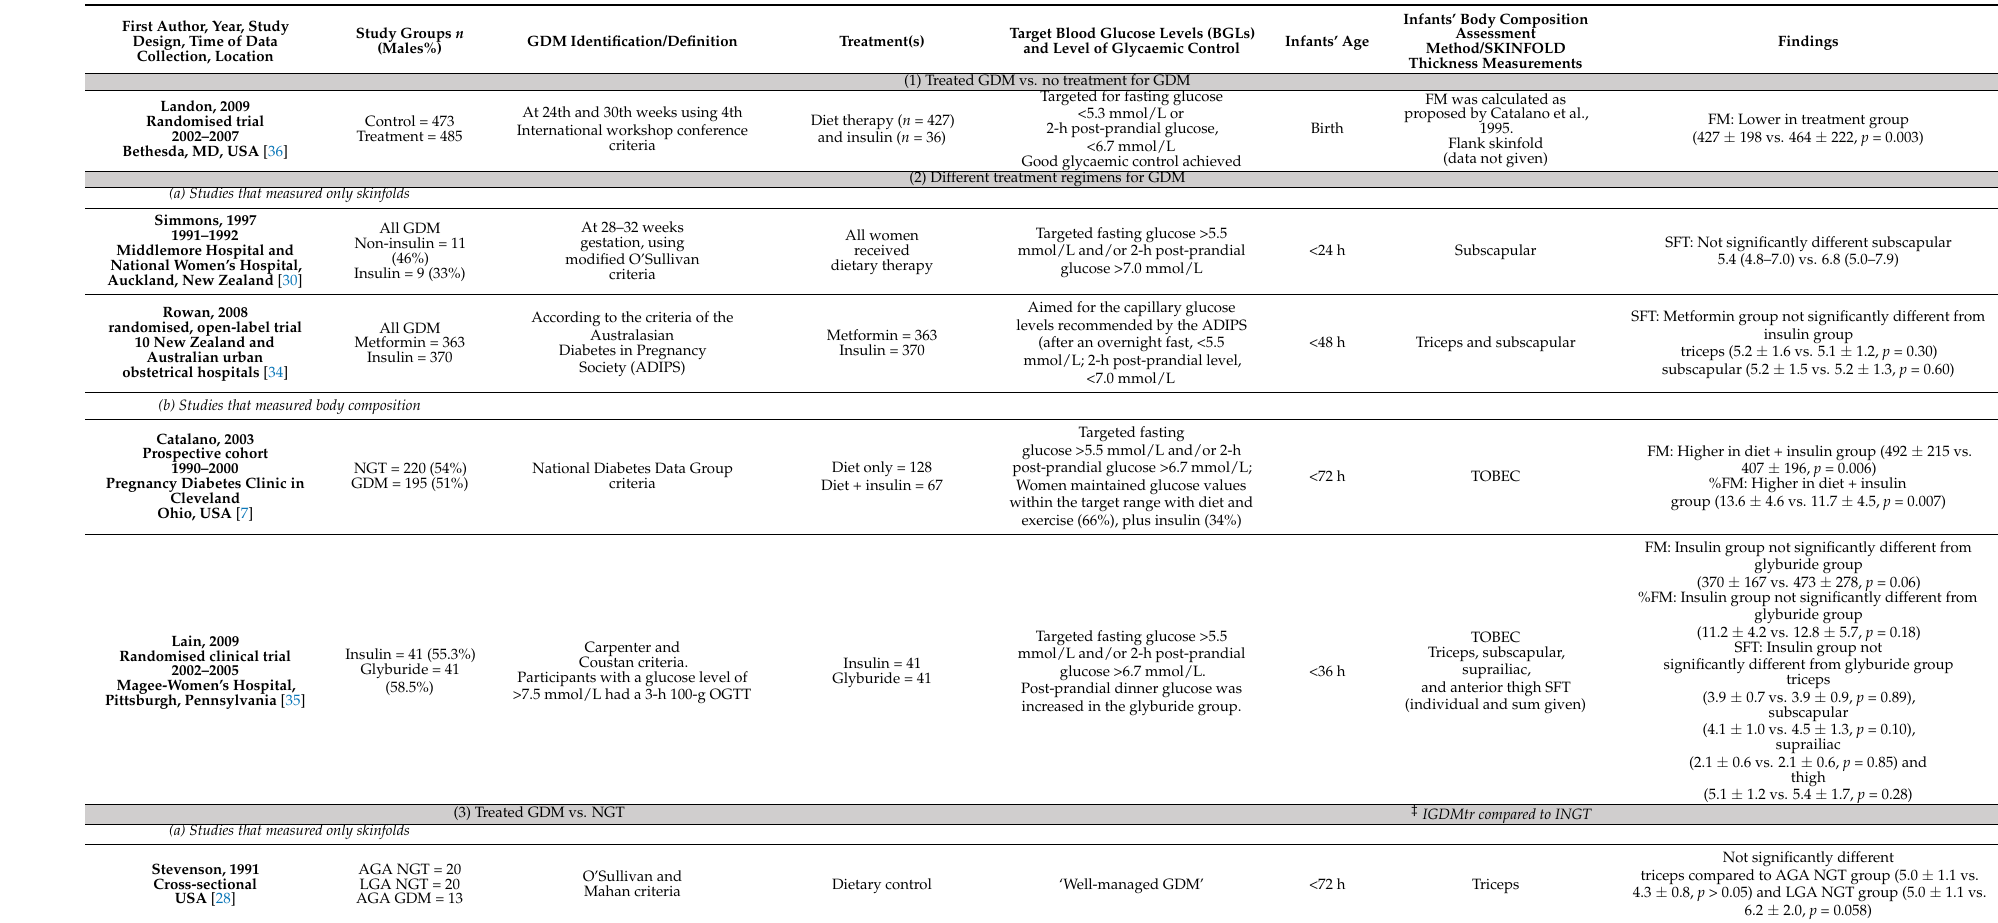
Table 1. Characteristics and findings of the